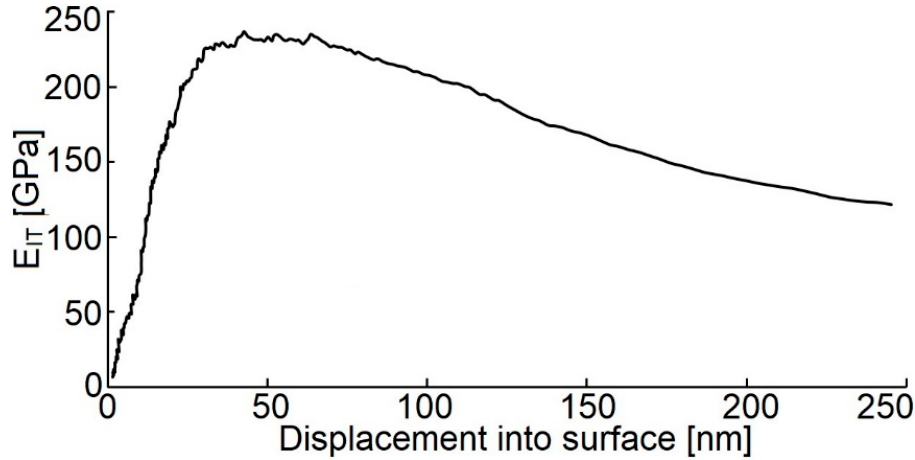
Figure 8. Depth profile of the E IT values of the tested WC/C coating.